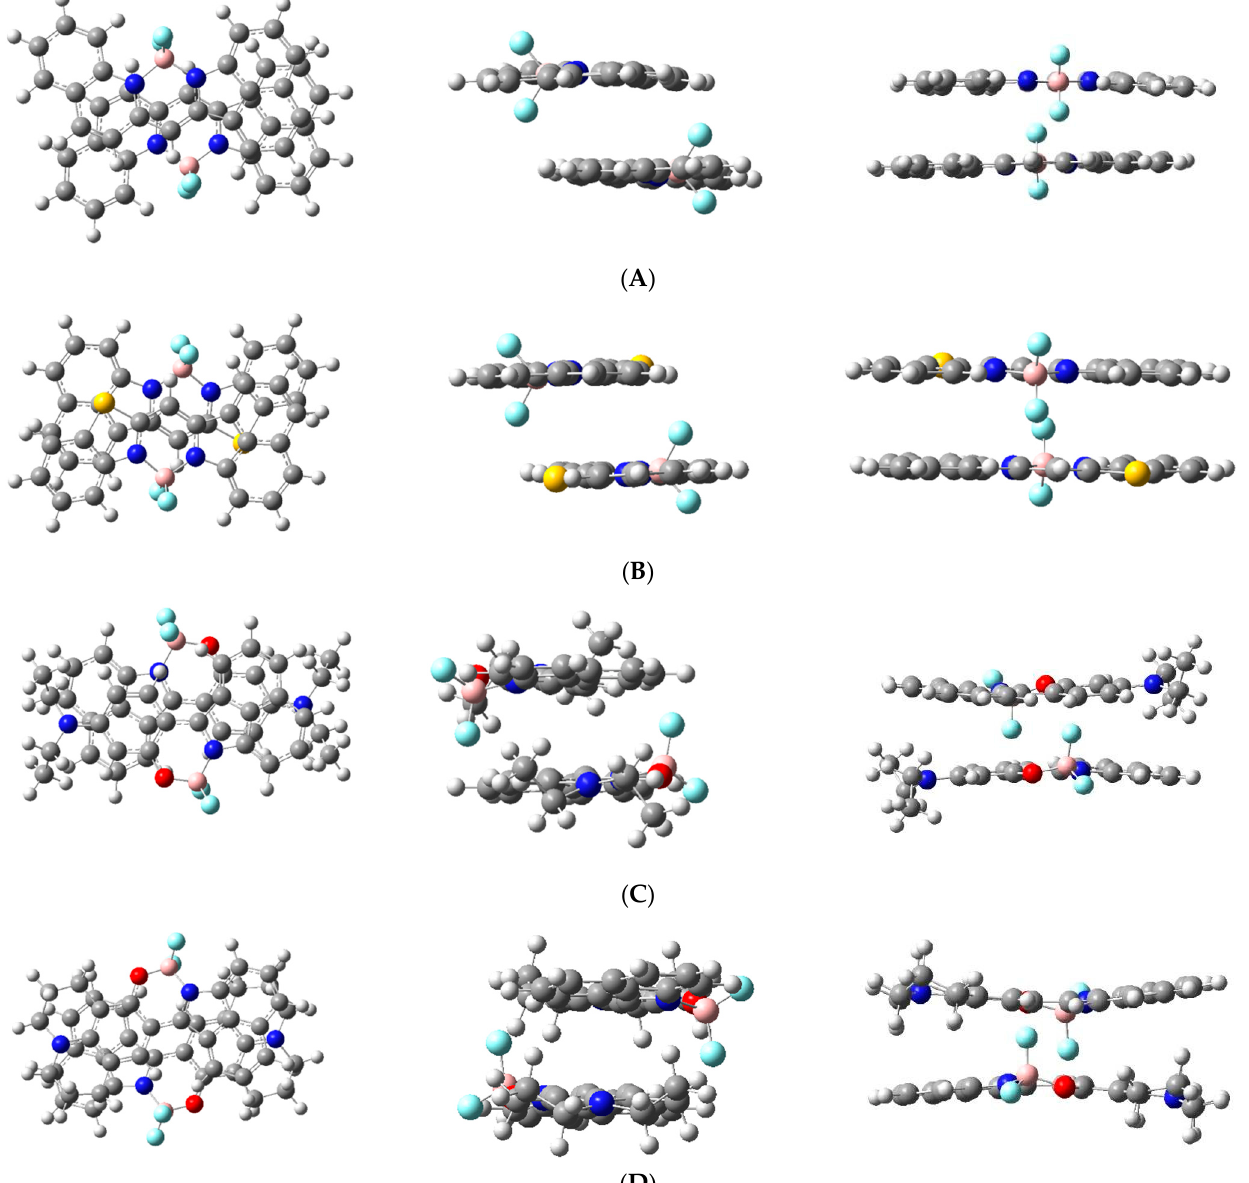
Figure 10. Molecular geometry of dimers of compounds I ( A ), II ( B ), III ( C ), IV ( D ), optimized by method DFT (WB97XD) in ground state.